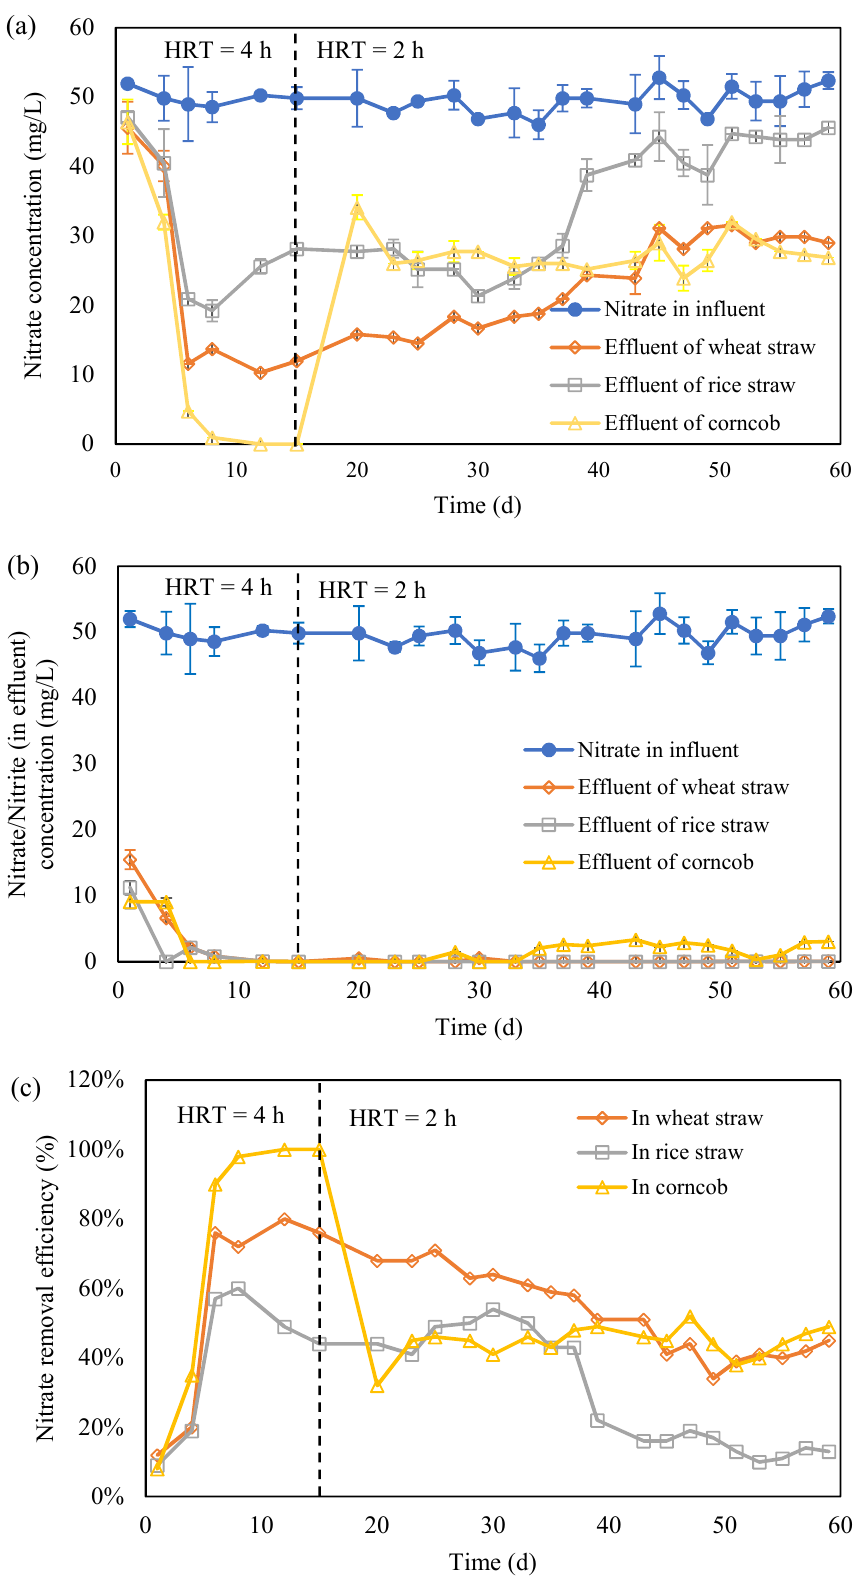
Figure 2. The heterotrophic denitrification with the three crop residues (HRT presents the hydraulic retention time; ( a ): nitrate concentration variation; ( b ): nitrate and nitrite concentration variation; ( c ): nitrate removal efficiency).